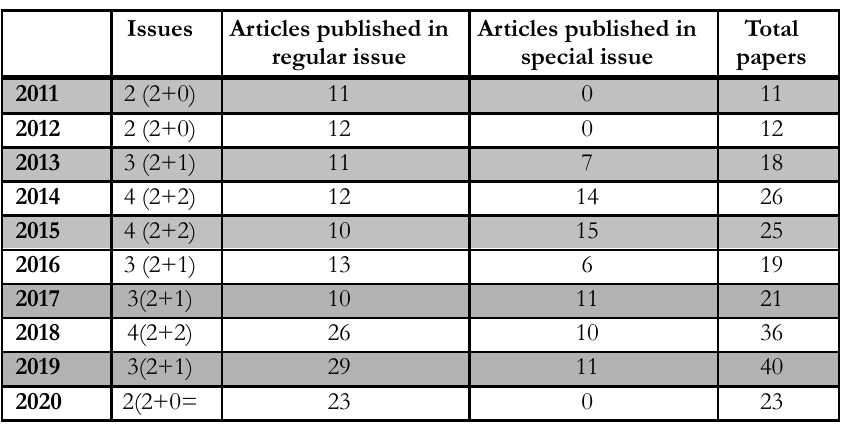
Table 2. Articles published evolution from 2010 to